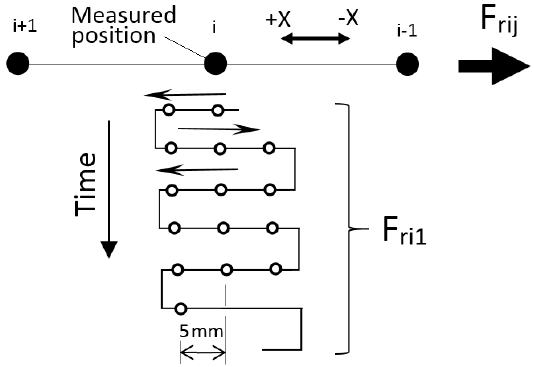
Figure 6. The third measurement scenario scheme. F rij —Force in the “r” direction, in the “i” position, with the load “j”. F ri1 —Force applied in the first cycle, demonstrated as the first load value. Each point of load is obtained as the mean of deviations from the five alternating runs. Thus, the stiffness course is obtained. As in previous cases of experiments number 1 and 2 respectively, the trend line slope here, too, indicates stiffness. The courses in these experiments are likely to be approximately linear. Therefore, a single value is sufficient to define the SSaS